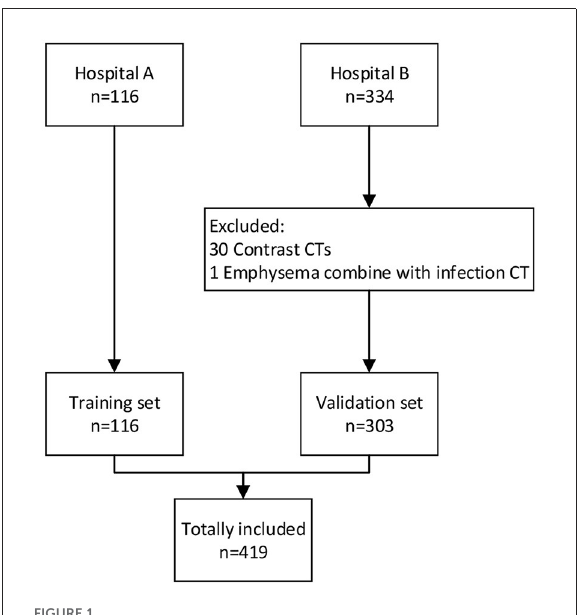
FIGURE1 The flowchart for the selection of the